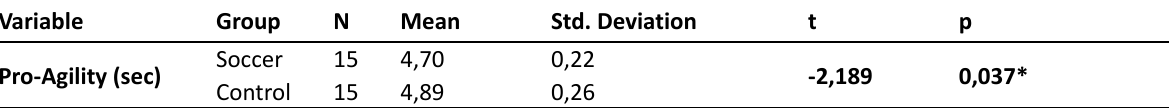
Table 2. Comparison of pro-agility parameters of football and the control group Variable